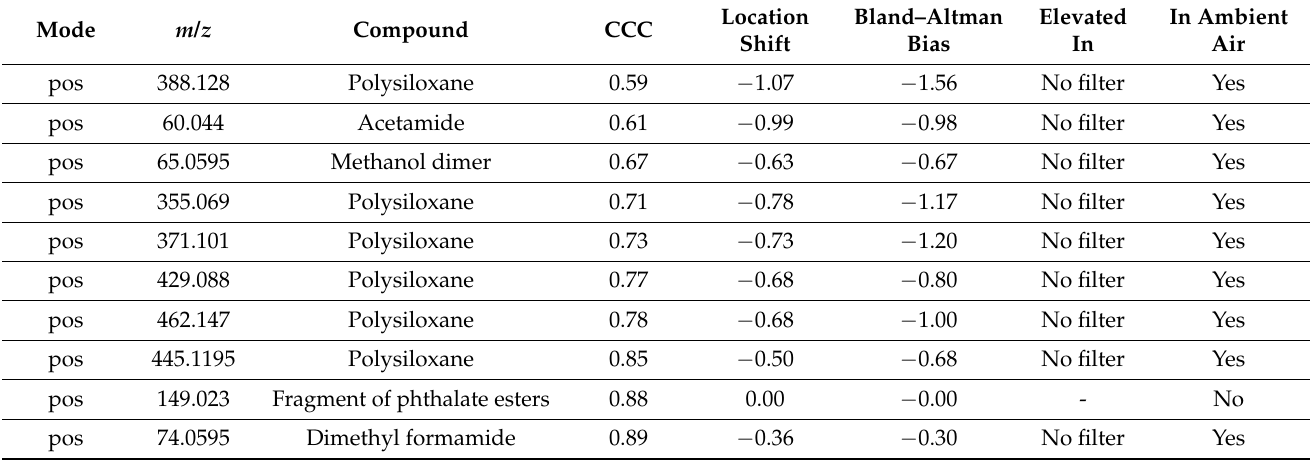
Table 2. Environmental contaminants that had a CCC < 0.9 agreement before and after filter usage. The location shift and Bland–Altman bias indicate whether the intensity was increased (positive values) or decreased (negative values) with filter